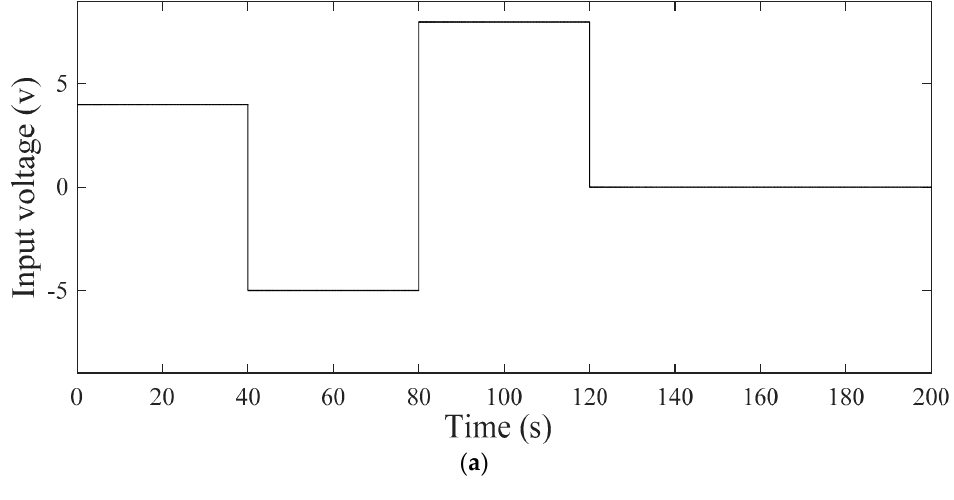
Figure 9. Bending of the printed actuator ( a ) before applying voltage; ( b ) under applied voltage.